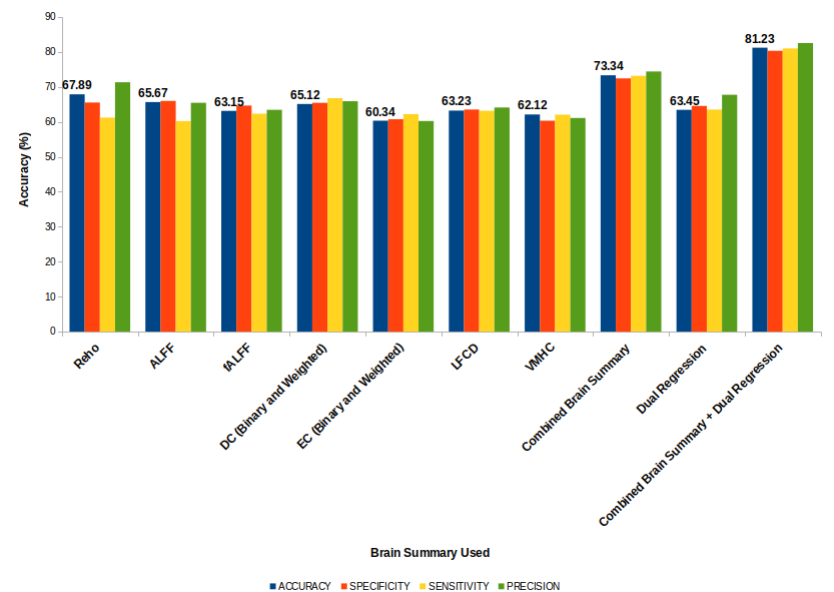
Figure 8. Accuracy of the Proposed